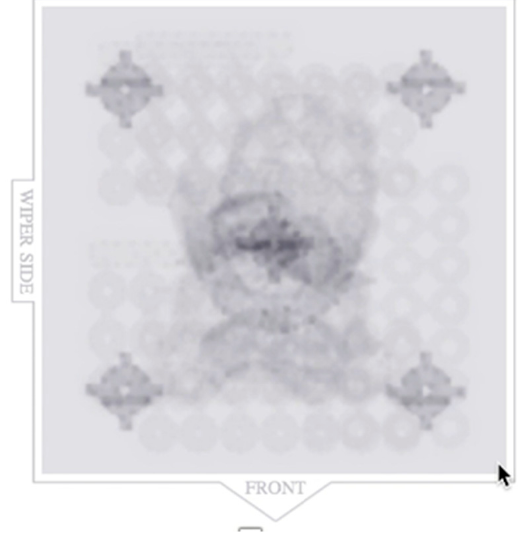
Figure 4. Heat map feature on the dashboard of 3D printing account (Formlabs, Somerville, MA, USA) showing placement of the previously printed objects on the build platform.